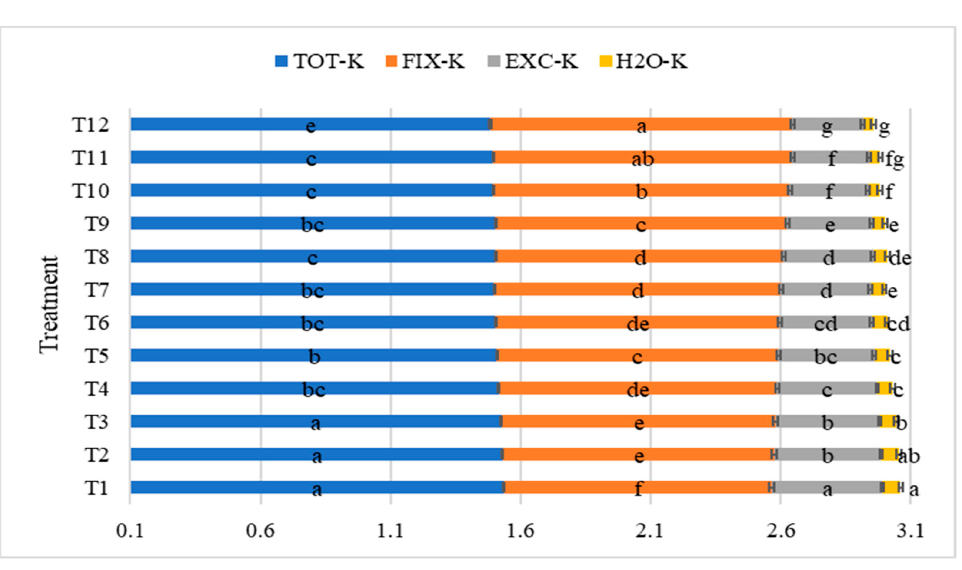
Figure 2. Effect of potassium (K) treatments on the percentage of total K (TOT-K), fixed K (FIX-K), exchangeable K (EXC-K), and water-soluble K (H 2 O-K) in the soil after strawberry harvesting at the combined two studied seasons. Values were the mean of six replicates. Di ff erent le tt ers within the columns indicate that there were signi fi cant di ff erences at a 0.05 level of probability.